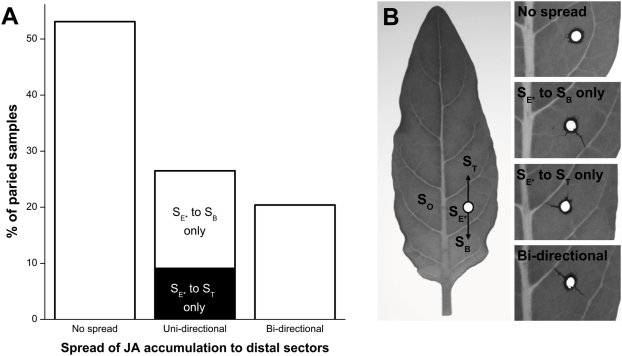
Spread of the JA burst from elicited to adjacent unelicited laminal sectors within a leaf were highly variable and likely depended on the connectivity of minor vasculature across sectors.(A) Of the 98 elicited leaves that accumulated JA in the elicited sectors (SE*) approximately half did not accumulate more than 500 ng/g JA in either of the adjacent, non-elicited sectors located proximal or distal to SE* (SB and ST), while the others accumulated JA in either SB, ST, or both adjacent sectors. Only 2 of the 112 leaves accumulated detectable quantities of JA in SO (data not shown), the sector on the opposite side of the midrib from SE*. (B) Crystal violet dye (2%) applied to the elicitation sites allowed the visualization of apoplastic transport within leaves. Dye either was (1) not taken up, or transported (2) towards the base of the leaf, (3) the tip of the leaf, or (4) in both directions.